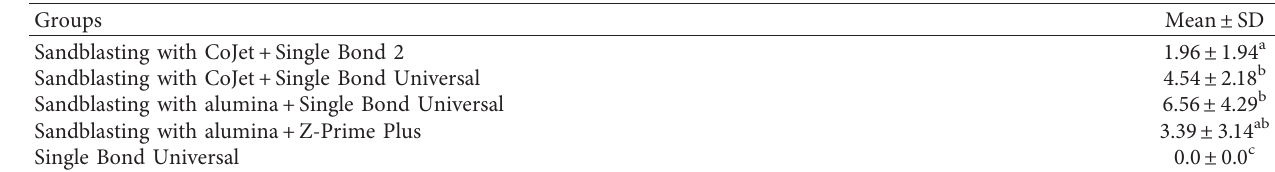
Table 2: Mean and SD of shear bond strength of the groups (MPa).